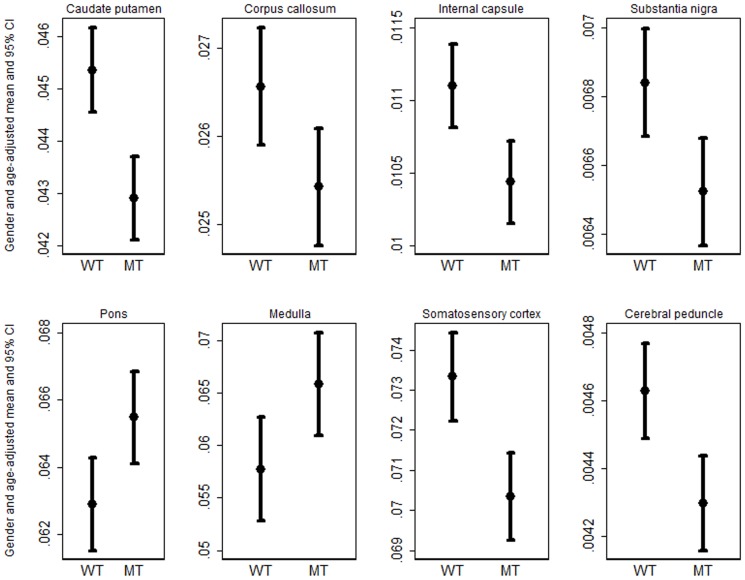
Average and 95% CI of the adjusted brain volume between NL-3 and wild type animals studied from eight out of the 39 regions that showed significant differences in volume.